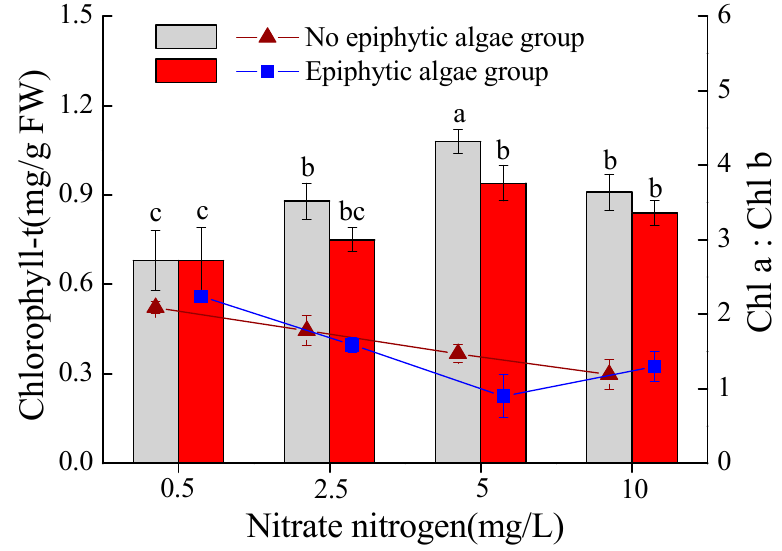
Figure 4. Total chlorophyll content and the chl-a/chl-b ratio of V. natans (mean ± SE, n = 3) in the epiphytic algae group and no epiphytic algae group under four nitrate-N concentrations. Bars with different letters indicate significant differences among treatments ( p < 0.05).